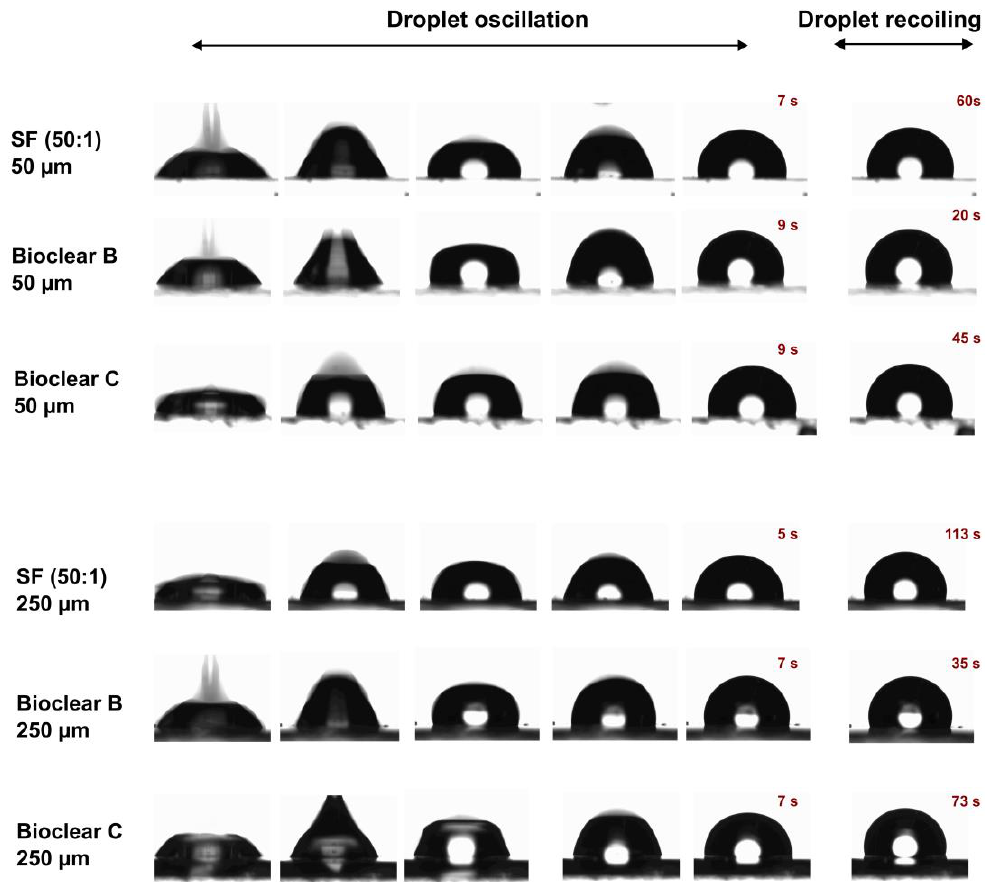
Figure 3. Image sequences of water droplet impacting on the soft PDMS surfaces: SF (50:1), Bioclear B, and Bioclear C with different thicknesses (50 µm and 250 µm).